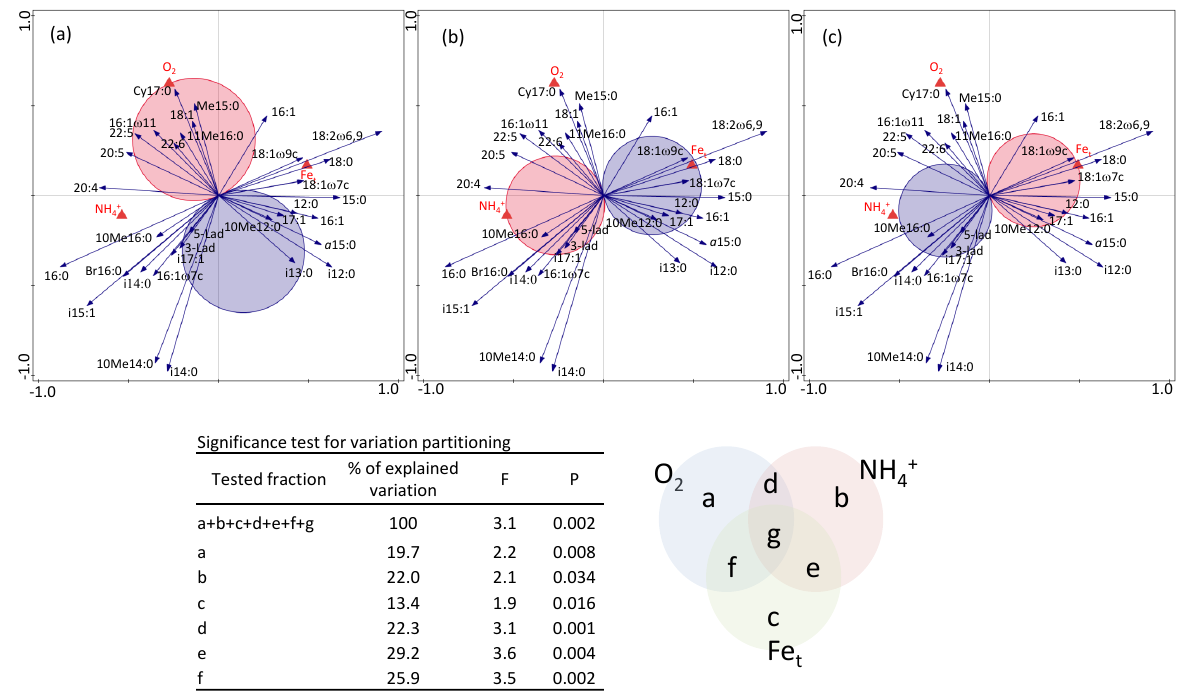
Figure 6. Variation-partitioning t -value biplots showing the PLFAs significantly correlated with the environmental variables (a) O 2 , (b) Fe t and (c) NH + . Results of the significance test of the variation partitioning are shown in the associated table. The PLFAs are represented 4 by arrows projecting from the origin. Concentration changes, between sampling data of a particular PLFA, are significantly related to concentration changes in the environmental variables, when the arrow tip of those PLFA is enclosed within circles. The arrow tip is enclosed within the red circle for positive correlation and inversely within the blue circle for negative correlation.